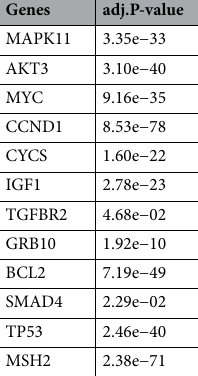
Table 4. The candidate genes in rectal cancer patients.